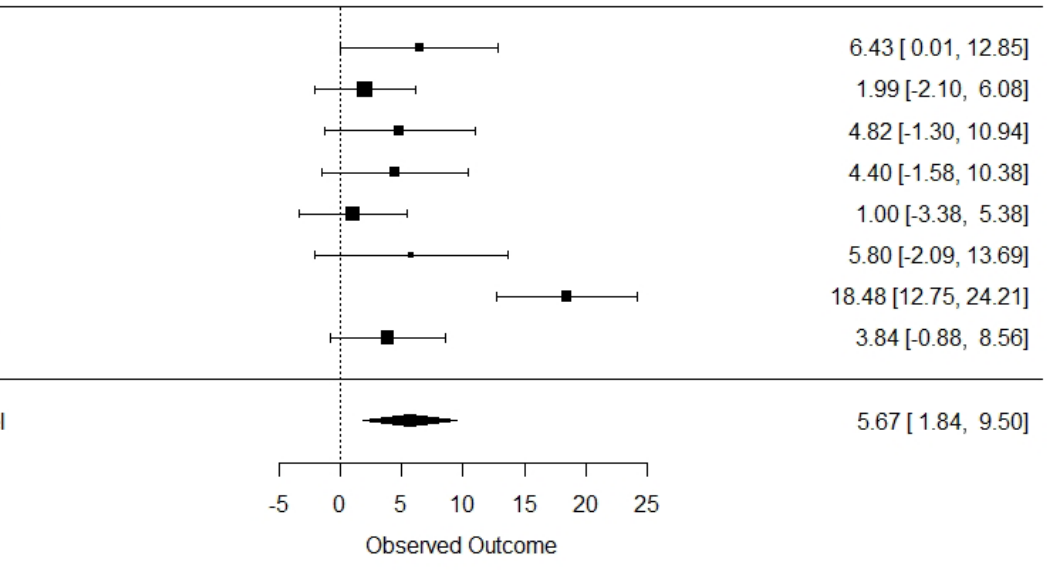
Figure 11. Forest plot evaluating dead heart damage caused by stem borer. For each study, in this figure, a horizontal line indicates the standard effect size of dead heart damage estimate (the rectangular box in the centre of each line) and 95% CL for the risk ratio used. The diamond at the bottom of the figure represents the combined estimate for all of the studies and its 95% confidence interval (width). Study 1: Pathak et al., 2013 [24]; Study 2: Karthikeyan et al., 2014 [3]; Study 3: Karthikeyan et al., 2010 [13]; Study 4: Padmavathi et al., 2009 [15]; Study 5: Jayakumar and Sankari, 2010 [25]; Study 6: Visalakshmi et al., 2014 [26]; Study 7: Yashpal Singh et al., 2015 [27]; Study 8: Kakde and Patel, 2018 [28].